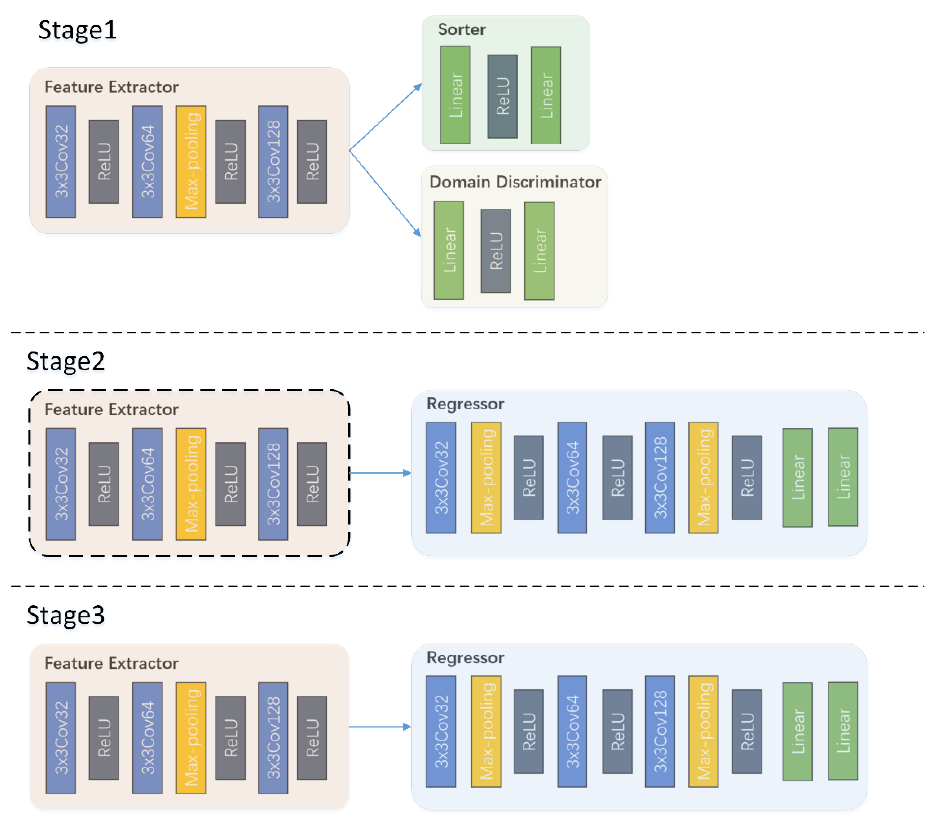
Figure 3. Network architecture.